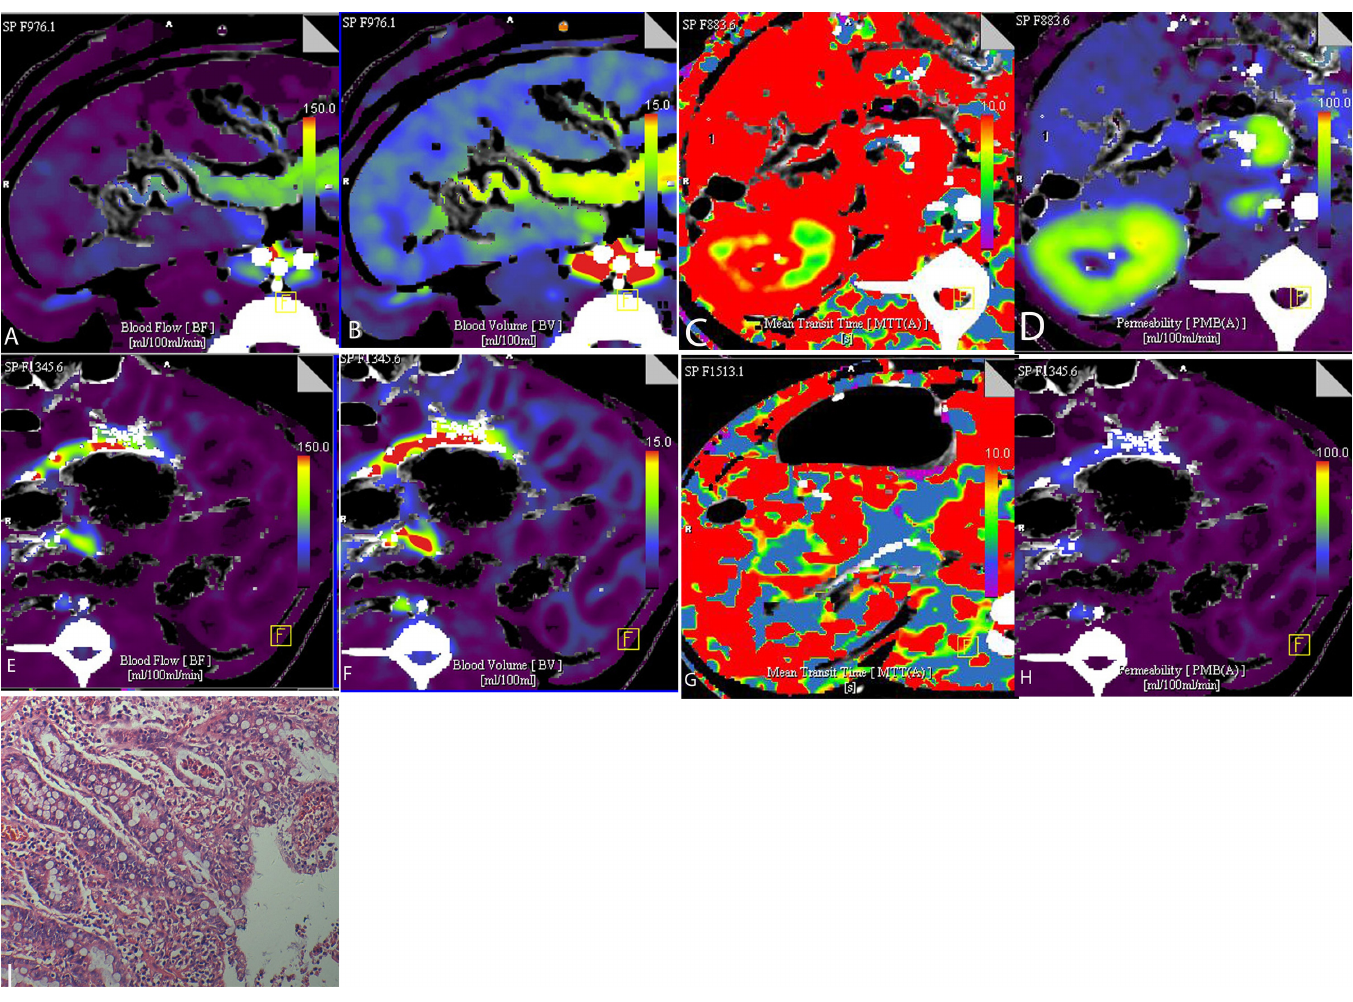
Fig 5. Color maps of CT perfusion parameters. The BF value (E), BV value (F), MTT (G) and PS (H) maps for reperfusion of 4 h reveal that the BF, BV, and PS values are significantly decreased as compared to SO group(A-D). Microscopic ileal histology images show epithelial clefting, villi denudation (Chiu ’ s score 4) in IR groups (I, HE × 100).)